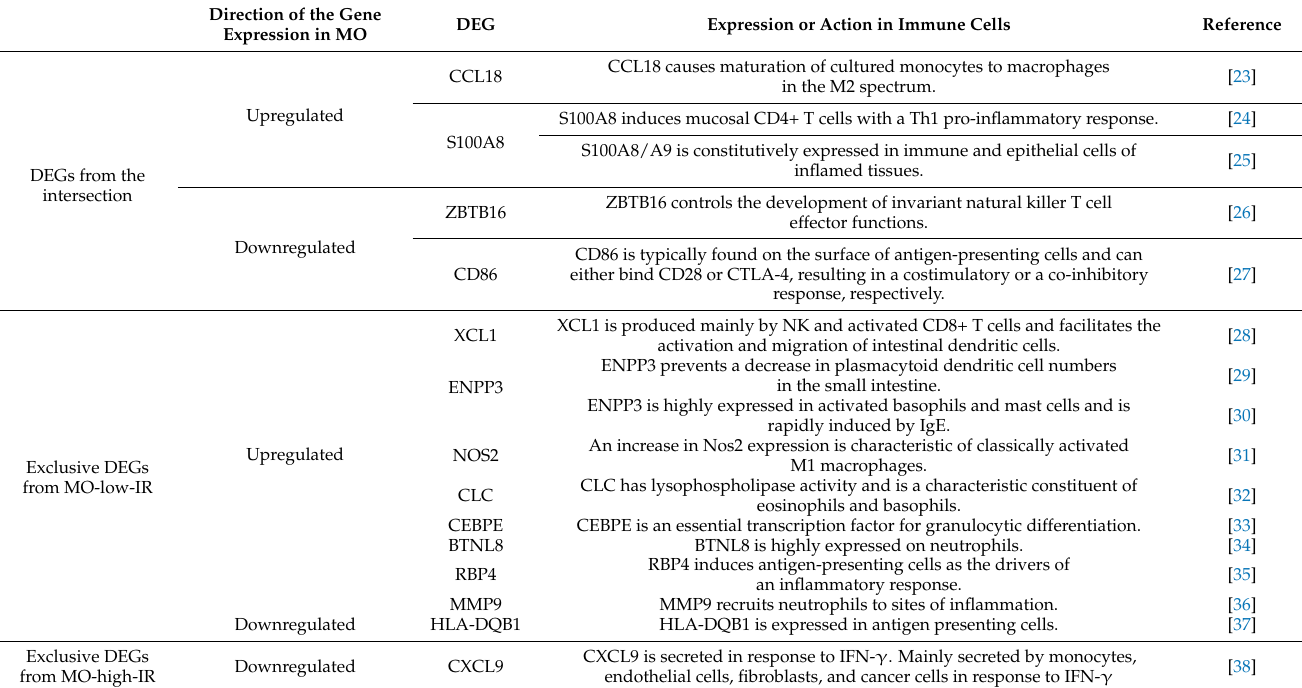
Figure 4. Representation of the Log 2 of fold change of the differentially expressed genes (DEGs) related to pro- and anti-inflammatory processes. Table 3. Bibliographic analysis of differentially expressed genes (DEGs) (FDR < 0.05) that are ex- pressed or involved in the migration, proliferation, activation, or maturation of different immune